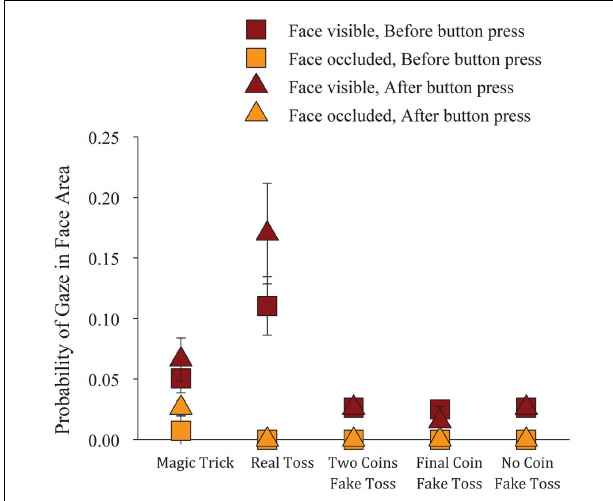
FIGURE 9 | Probability of the subjects’ gaze on the magician’s face area 500ms before versus 500ms after the button press. Error bars indicate one